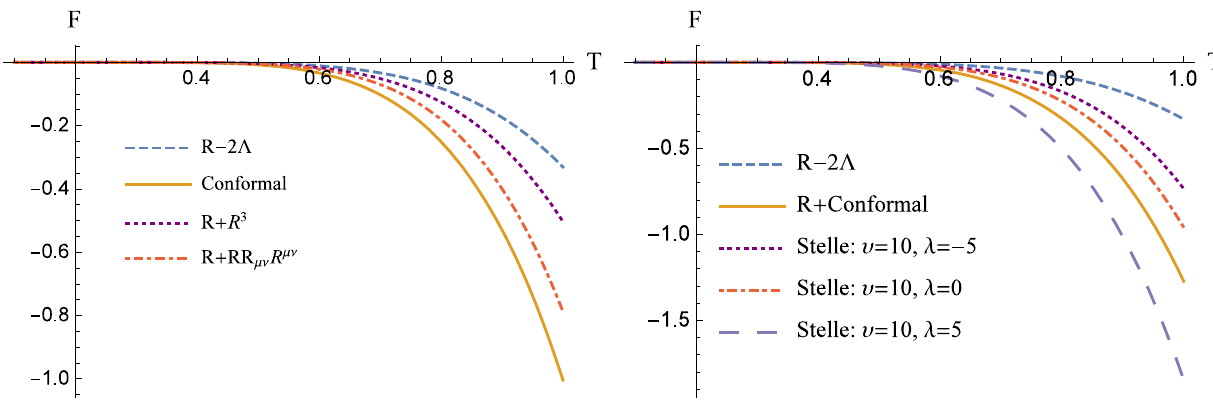
Fig. 1 One-loop correction to the free energy in special cases of f ( R , R μν R μν ) . We have assumed (cid:10) = − 1 and η = 1. The values for υ and λ